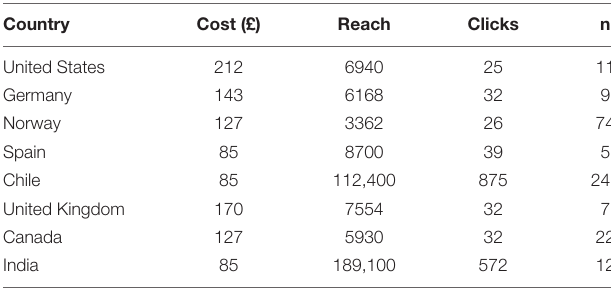
TABLE 4 | Social media recruitment costs and